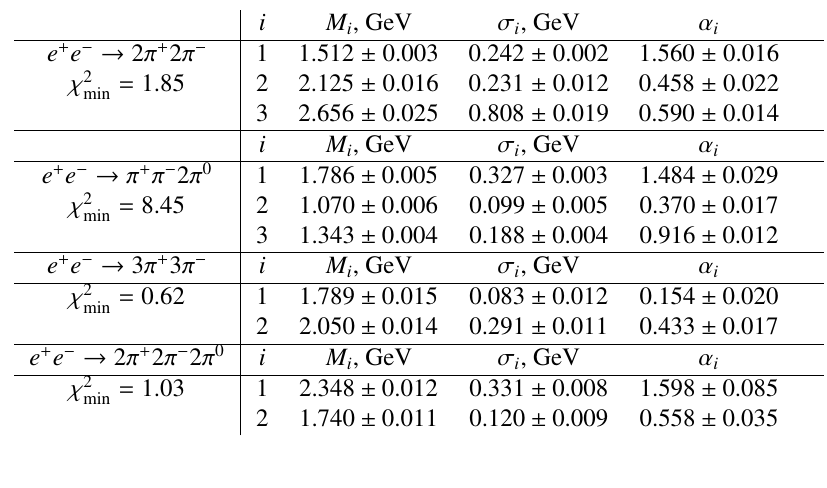
Table 2. The fitting results for particular e + e − -annihilation